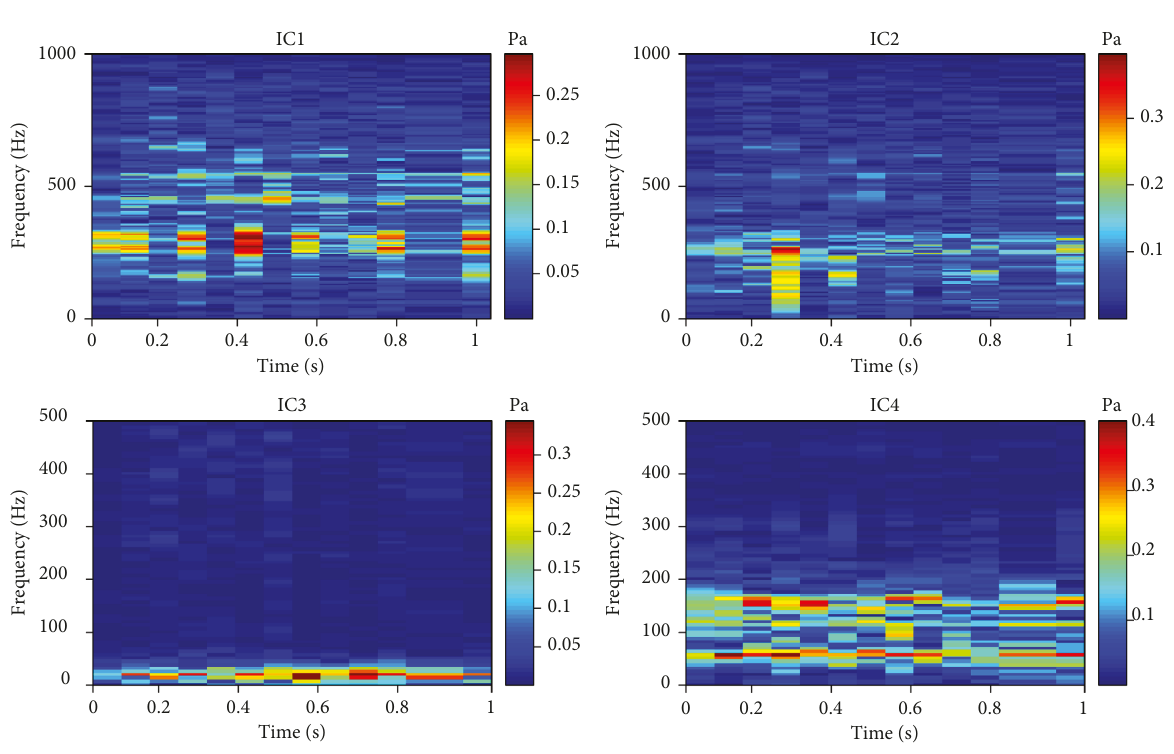
Figure 15: Spectra of IC1 to IC4.